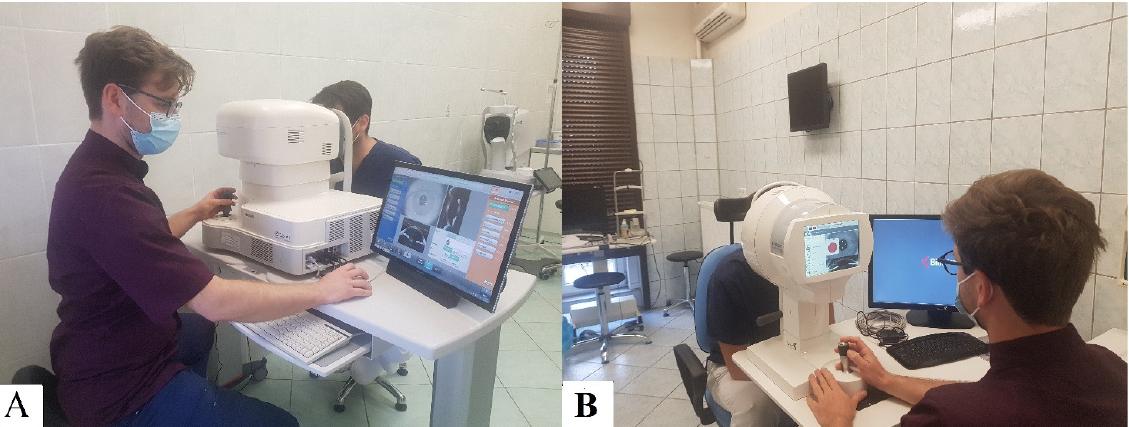
Figure 1. Figure presenting the measurement made with the compared devices. ( A )—OCT Cassia 2. ( B )—Galilei G6 Dual Scheimpflug Analyzer.